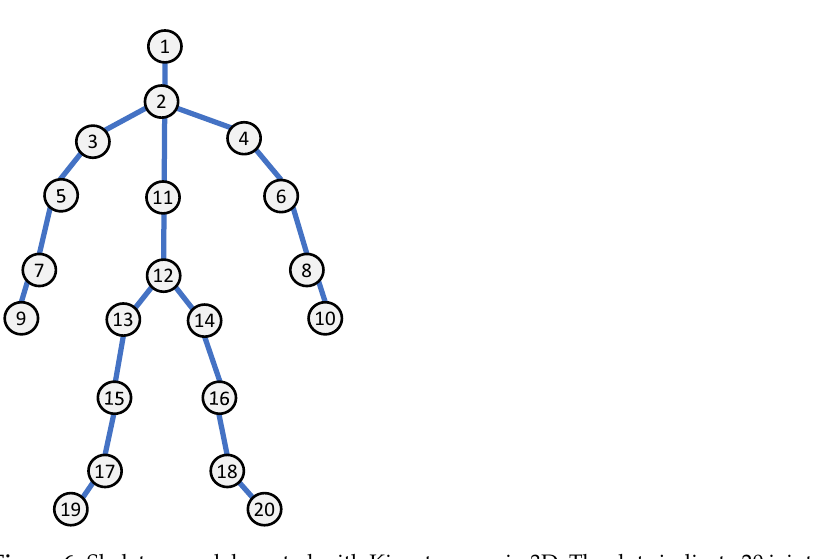
Figure 6. Skeleton model created with Kinect sensor in 3D. The dots indicate 20 joints, while the lines represent 19